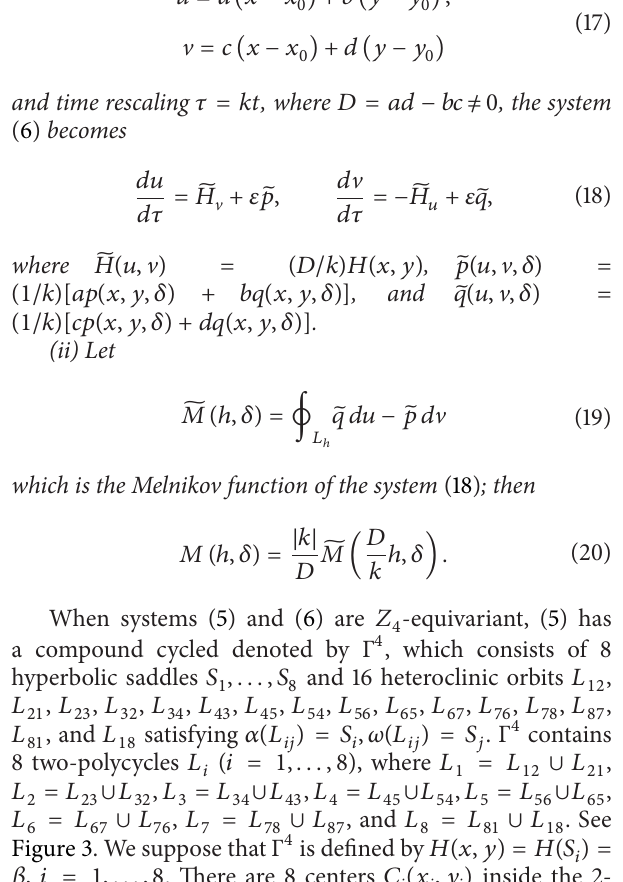
Figure 3. We suppose that Γ 4 is defined by 𝐻(𝑥, 𝑦) = 𝐻(𝑆 𝑖 ) = 𝛽 , 𝑖 = 1, . . . , 8 . There are 8 centers 𝐶 , with 𝐻(𝐶 1 ) = 𝐻(𝐶 3 ) = 𝐻(𝐶 5 ) = 𝐻(𝐶 7 ) = 𝛼 1 polycycle 𝐿 I and 𝐻(𝐶 2 ) = 𝐻(𝐶 4 ) = 𝐻(𝐶 6 ) = 𝐻(𝐶 8 ) = 𝛼 2 . There